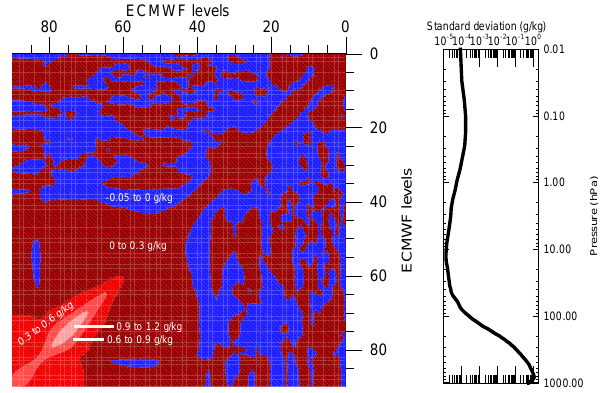
Fig. A3. Left: square root and sign of the (cid:10) δT i · δT j (cid:11) terms used in Eq. (A15), as function of model level (level 0 corresponds to the lowest pressure, level 90 to the ground level). Blue indicates error anti-correlation (negative covariance), red correlation (positive covariance) between the two corresponding levels. Right: standard deviation of the uncertainties in the temperature profiles as function of pressure (hPa), corresponding to the left array’s diagonal.